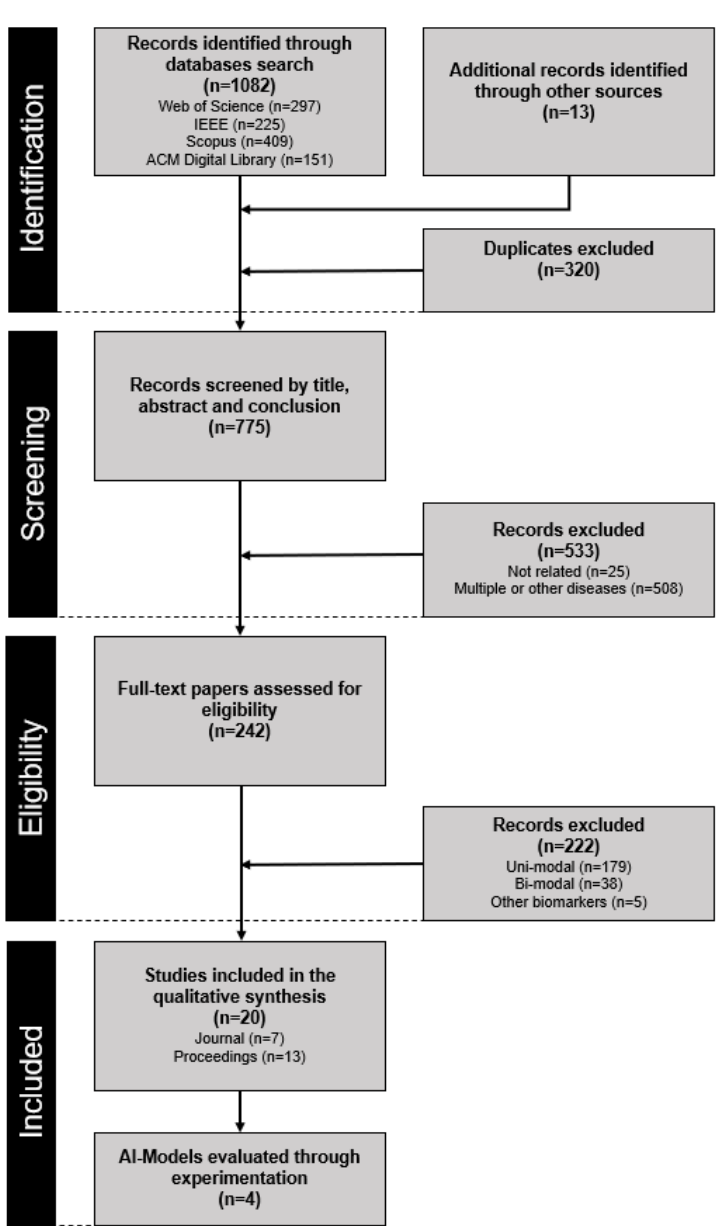
Figure 1. Flowchart of the search and study selection process.